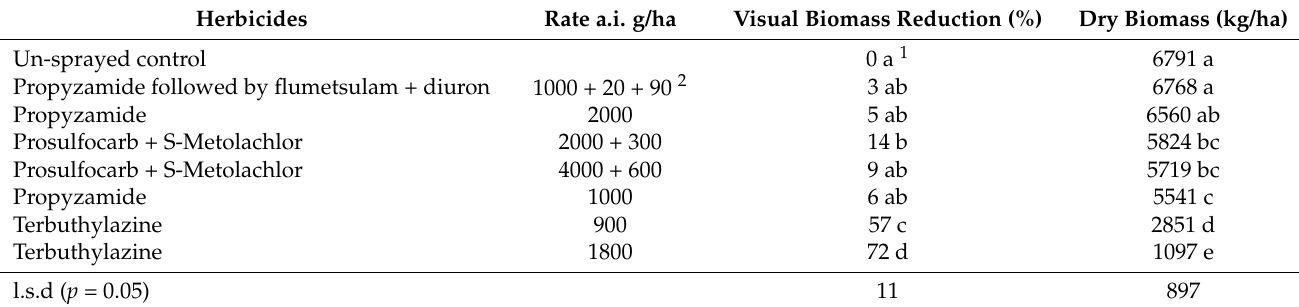
Table 10. Visual assessment on tedera biomass reduction taken on the 28 May 2020 and biomass cuts taken on the 25 August 2020, 2 and 5 months after the experiment was sown at